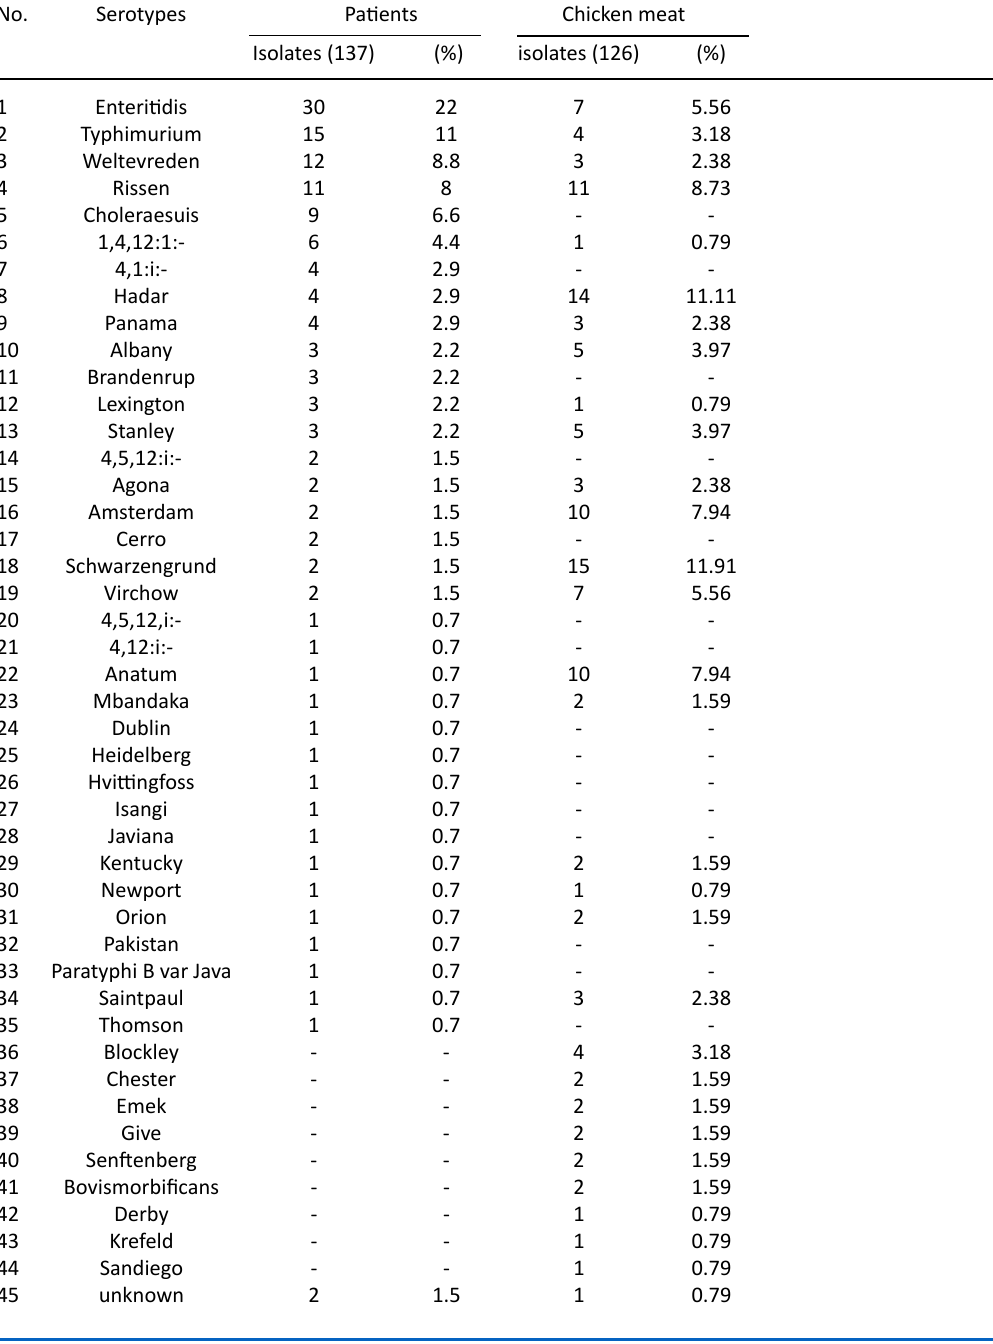
Table 3. Serotypes of Salmonella Enterica isolated from patients and chicken in Thailand during 2002.